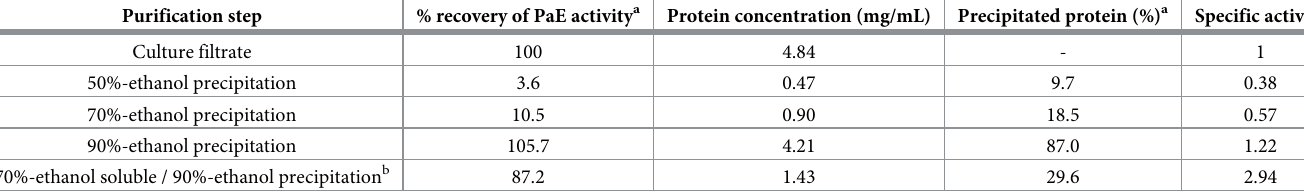
Table 2. Concentration of PaE by ethanol